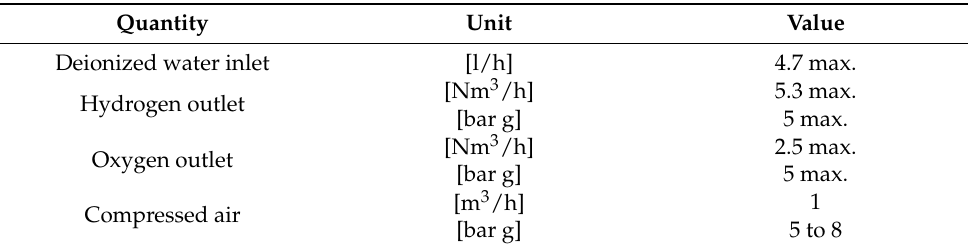
Table 3. Technical data of the alkaline electrolyser (FZ/001EL).